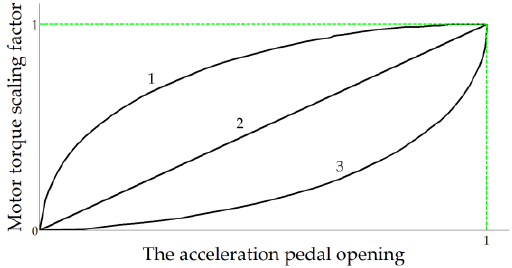
Figure 5. Three driving control strategies.